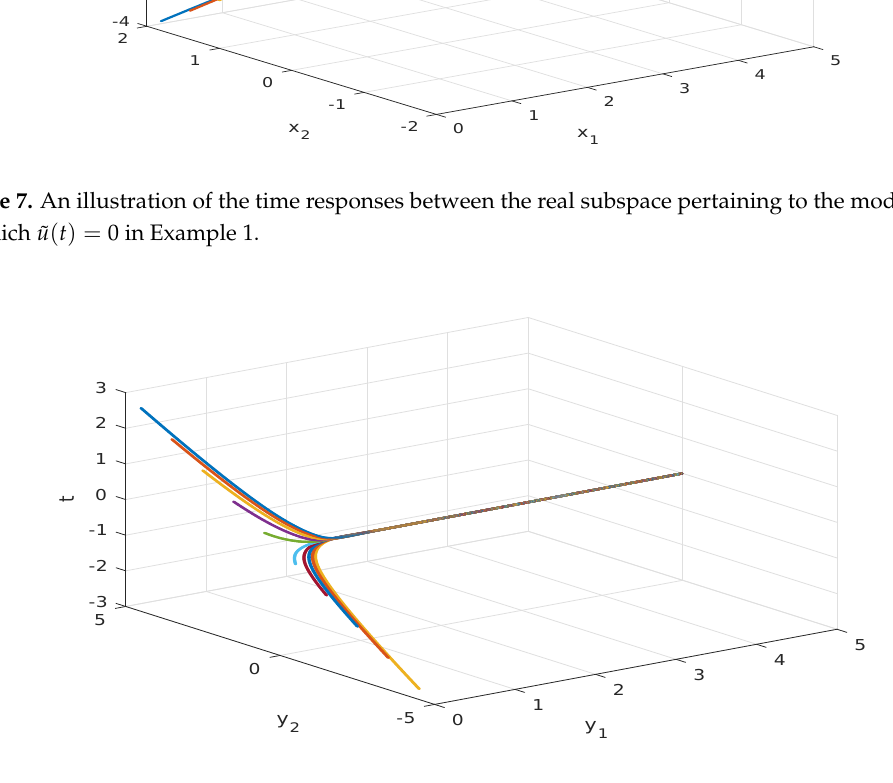
Figure 8. An illustration of the time responses between the imaginary subspace pertaining to the model in (20), in which ˜ u ( t ) = 0 in Example